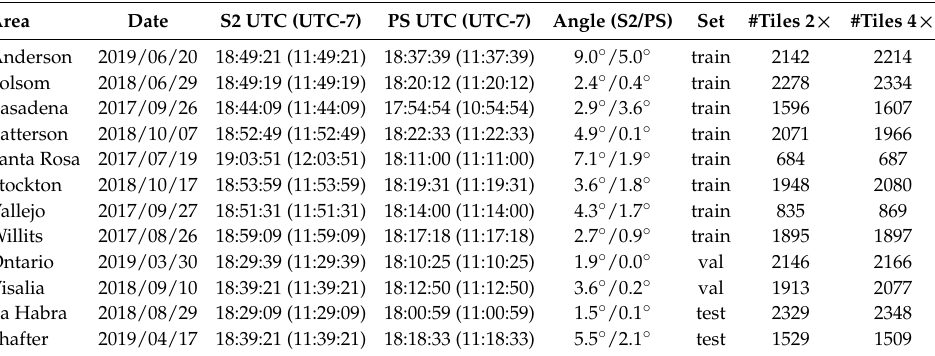
Table 1. Summary of the images used from S2 and PS to form our